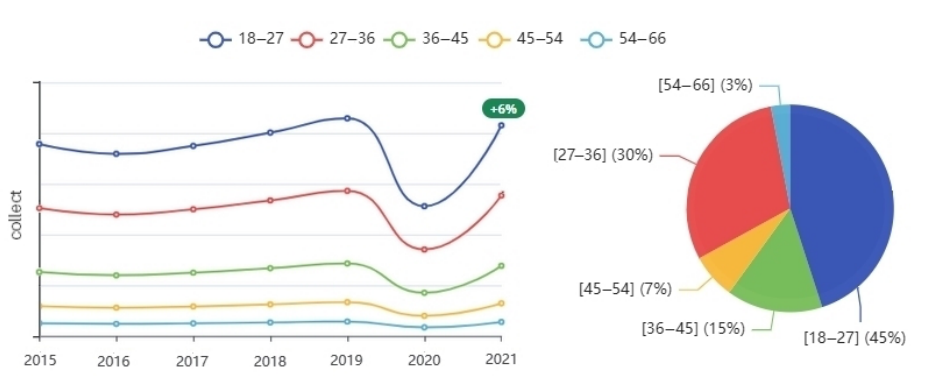
Figure 9. Number of donations by age group per year.